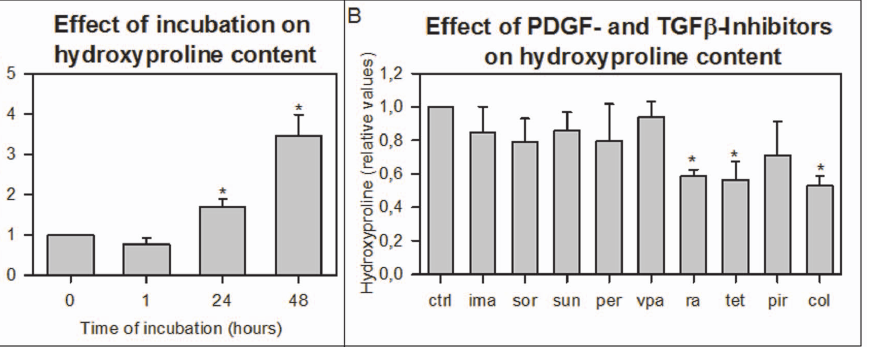
Figure 3. Hydroxyproline content of control fPCLS and fPCLS incubated with antifibrotic drugs. Hydroxyproline content in fPCLS incubated up to 48 hours (A) and with addition of 10 m M imatinib (ima), 2 m M sorafenib (sor), 5 m M sunitinib (sun), 100 m M perindopril (per), 1 mM valproic acid (vpa) 270 m M rosmarinic acid (ra), 100 m M tetrandrine (tet), 2.5 mM perindopril (pir) and 200 nM colchicine (col) (B). n=3. Error bars represent SEM. *p , 0.05 vs 0h (A), *p , 0.05 vs ctrl 48h (B).